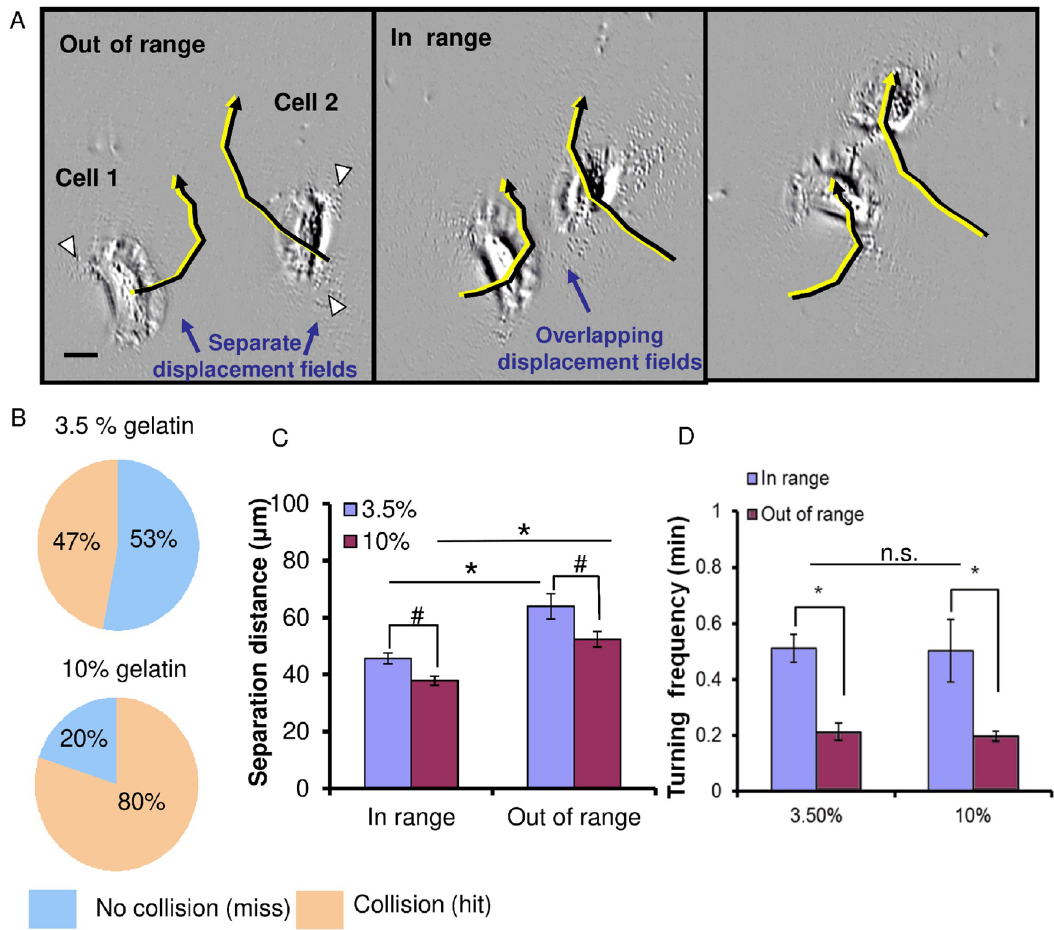
Fig 1. Part A. A pair of approaching cells displaying collision avoidance on a soft substrate. Time series of difference images of two cells is shown at 0, 3.3 and 6.7 minutes, respectively, as they move along the paths indicated (black and yellow lines). Initially, cell 1 (left) and cell 2 (right) are approaching each other but their bead displacement fields do not yet overlap. Bead displacements are proportional to substrate deformation and appear as black and white stippled areas at the rear, left and right cell edges (white arrow heads). At 3.3 minutes cell deformation fields start to overlap as cells are in range, and begin to turn away from each other. At 6.7 minutes cells are still in range but they are moving apart. Scale bar is 3.3 μm . Part B. The effect of surface stiffness on collision avoidance. Pie charts show the percentage of cells that collide (hit) or undergo collision avoidance (miss) on softer, 3.5% and stiffer, 10% gelatin gels. Part C. Histogram showing the average cell-cell separation distance at which the displacement fields of each cell first overlaps (in range) and separate (out of range) on softer (3.5% gelatin) and stiffer (10% gelatin) surfaces. For cell pairs in range, n = 60 (softer) and n = 23 (stiffer). For cell pairs out of range, n = 28 (softer) and n = 67 (stiffer). Part D. Histogram showing the frequency of turns when cells are in range or out of range, on softer ( n = 33, in range; n = 16, out of range) and stiffer surfaces ( n = 17, in range; n = 16, out of range). Data in B-D were obtained from 8 independent trials. � Denotes significance using a Wilcoxon signed rank test, where p � 0.001. # Denotes significance using a Mann-Whitney U test, where p � 0.01. Error bars represent